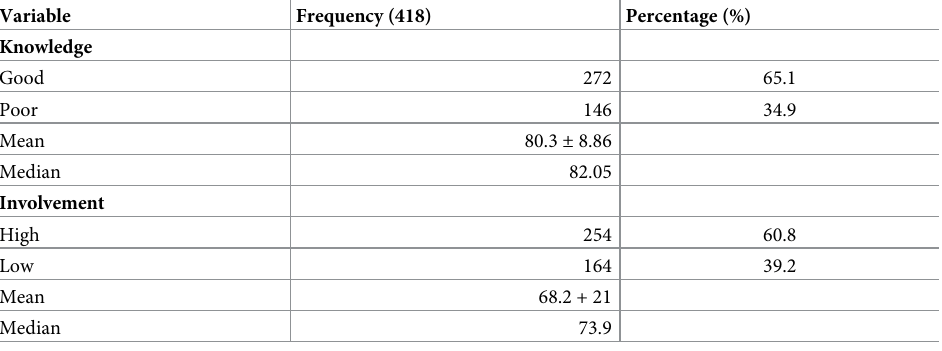
Table 7. Overall level of men’s knowledge and involvement in maternal, newborn and child health.